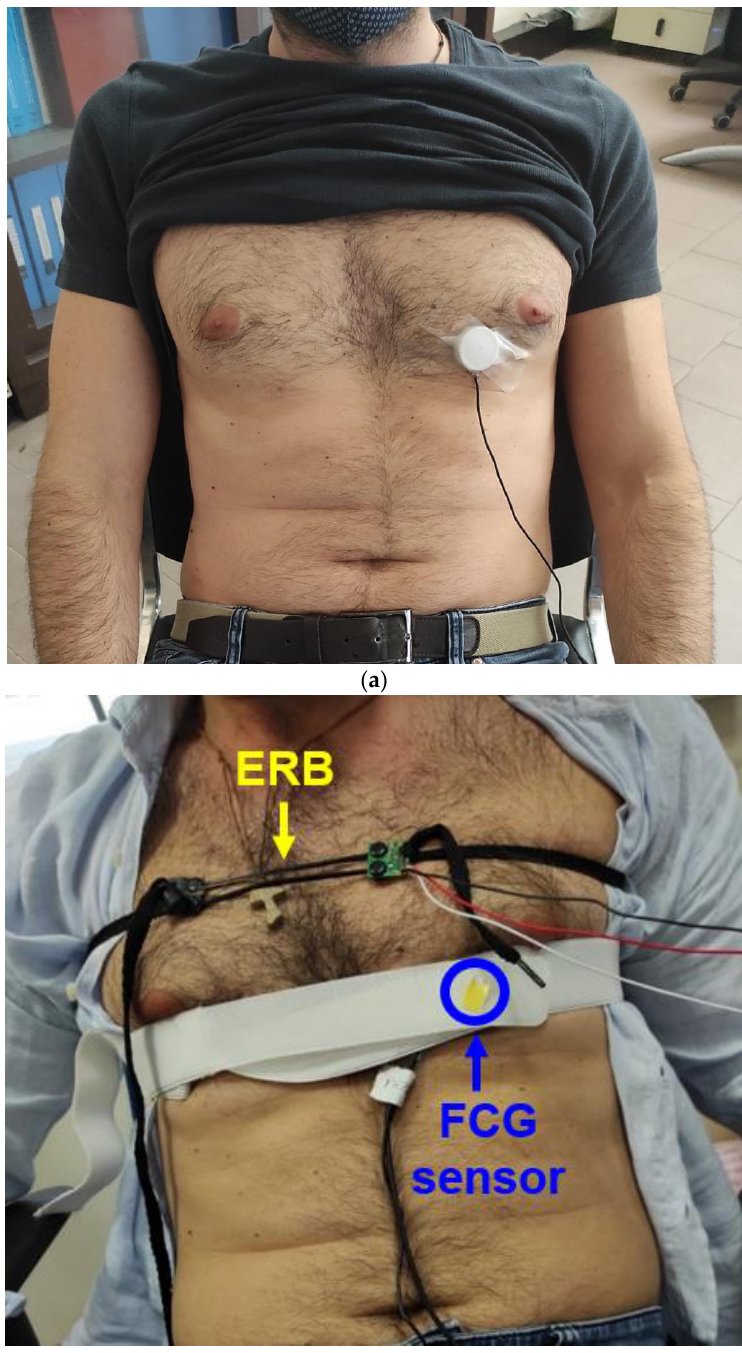
Figure 3. Example of ERB and FCG sensor placement on the chest of subject #7: ( a ) FCG sensor mounted on patient’s chest by means of medical adhesive tape; ( b ) FCG sensor secured on the chest via a belt fastened around the thorax, with the ERB mounted on the upper chest, so as not to interfere with the FCG sensor.